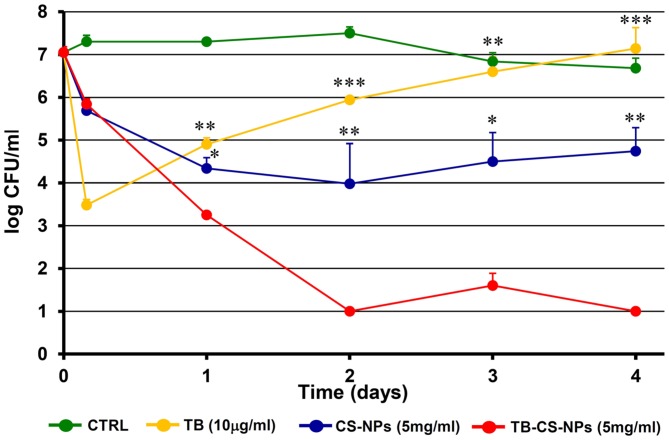
Kinetics of the antibacterial activity of the developed nanoparticle-based AMP-delivery system against Staphylococcus epidermidis ATCC35984. Bacterial cells were exposed for different time intervals to free TB, CS-NPs, or TB-CS-NPs. At the end of the exposure time aliquots of the cultures were serially diluted, plated on solid medium, and incubated at 37°C for 48 h before assessing the CFU count. Results are the mean values ± SEM of three independent experiments. CTRL, control bacteria incubated in the assay medium only. ∗p < 0.05; ∗∗p < 0.01; ∗∗∗p < 0.001 as compared to TB-CS-NPs, Student’s t-test.